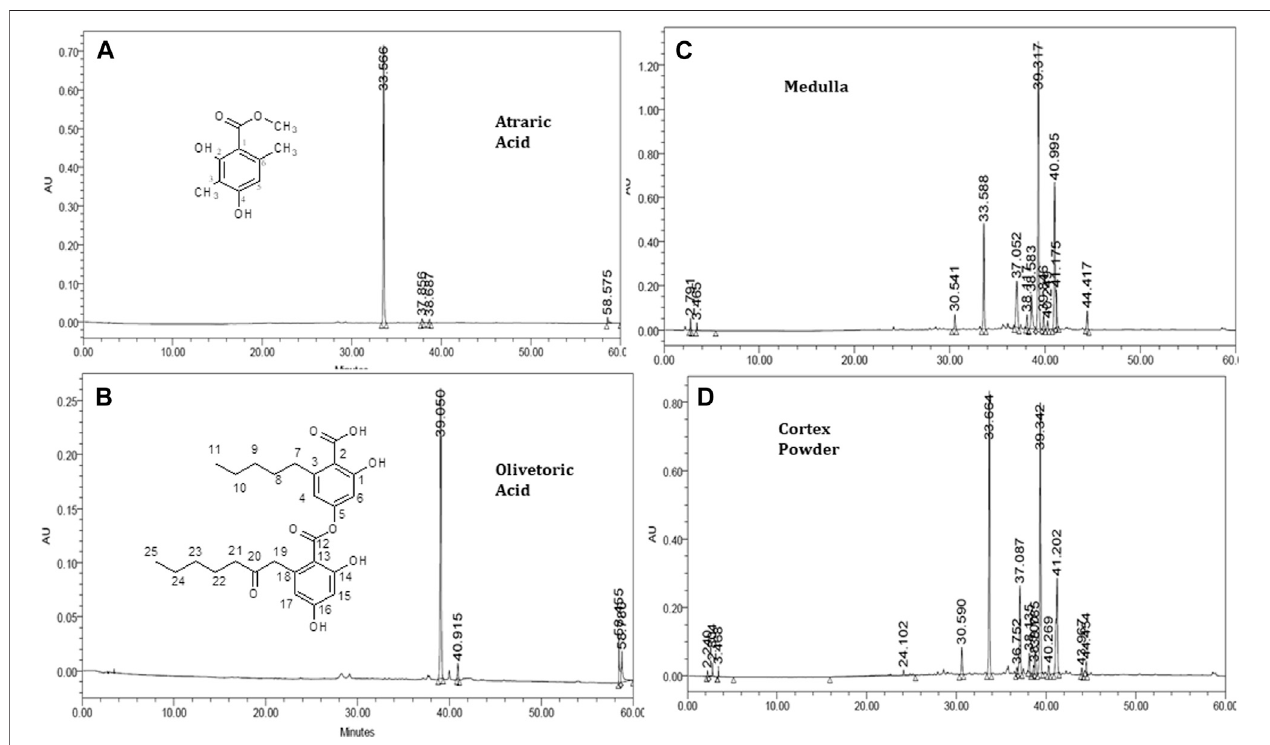
FIGURE 5 | HPLC chromatogram of Atraric acid (A) , Olivetoric acid (B) , Medulla pieces (C) , Cortex powder (D) .